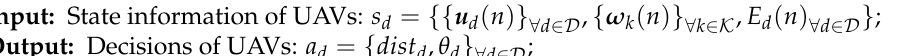
Algorithm 2 UAFC